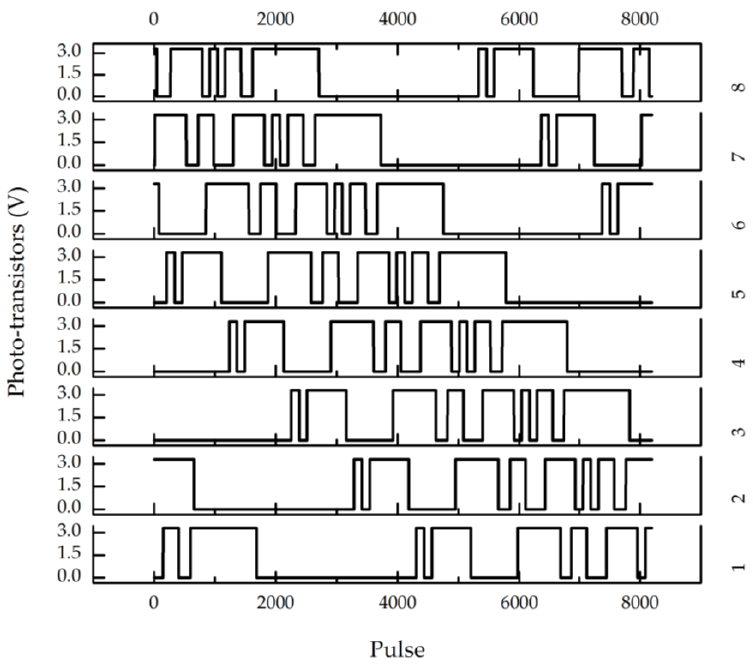
Figure 10. Outputs of the eight reading heads.